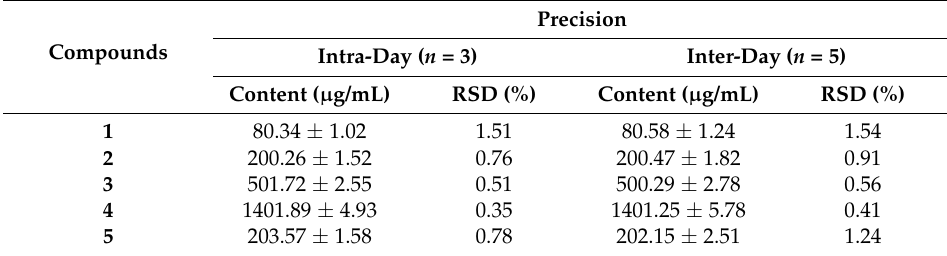
Table 4. Precision of the HPLC-DAD method for the five less polar ginsenosides.